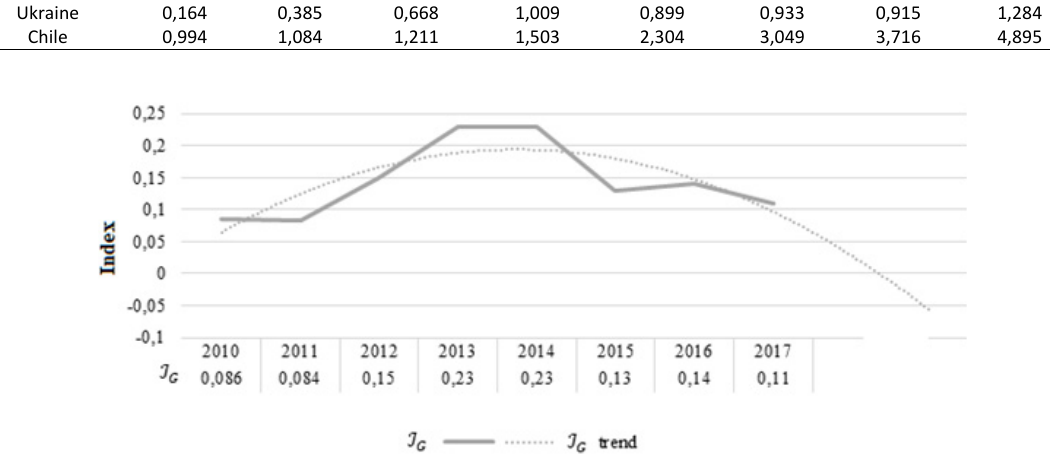
Fig. 2: NCRE generation index of Ukraine and Chile and graph of its dynamics 2010 vs 2017